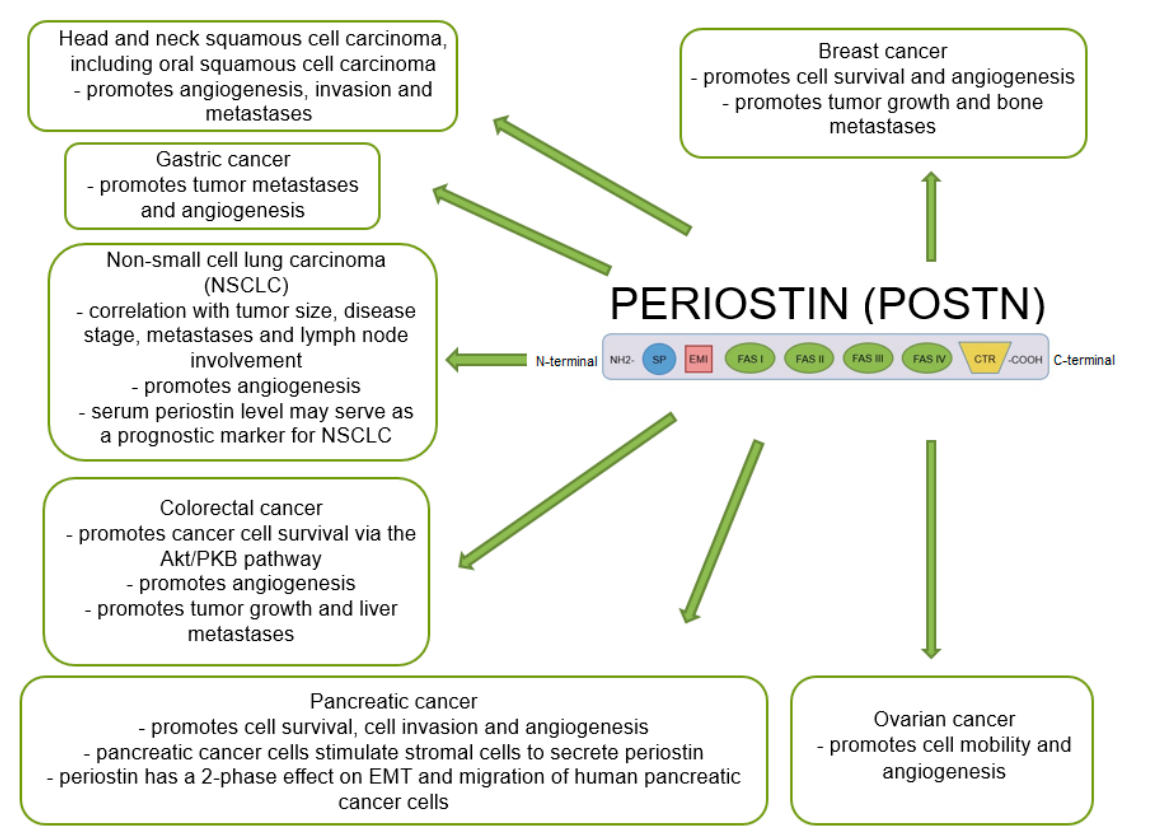
Figure 5. Schematic representation of the role of POSTN expression in various cancers (based on Ruan et al. [47], modified).